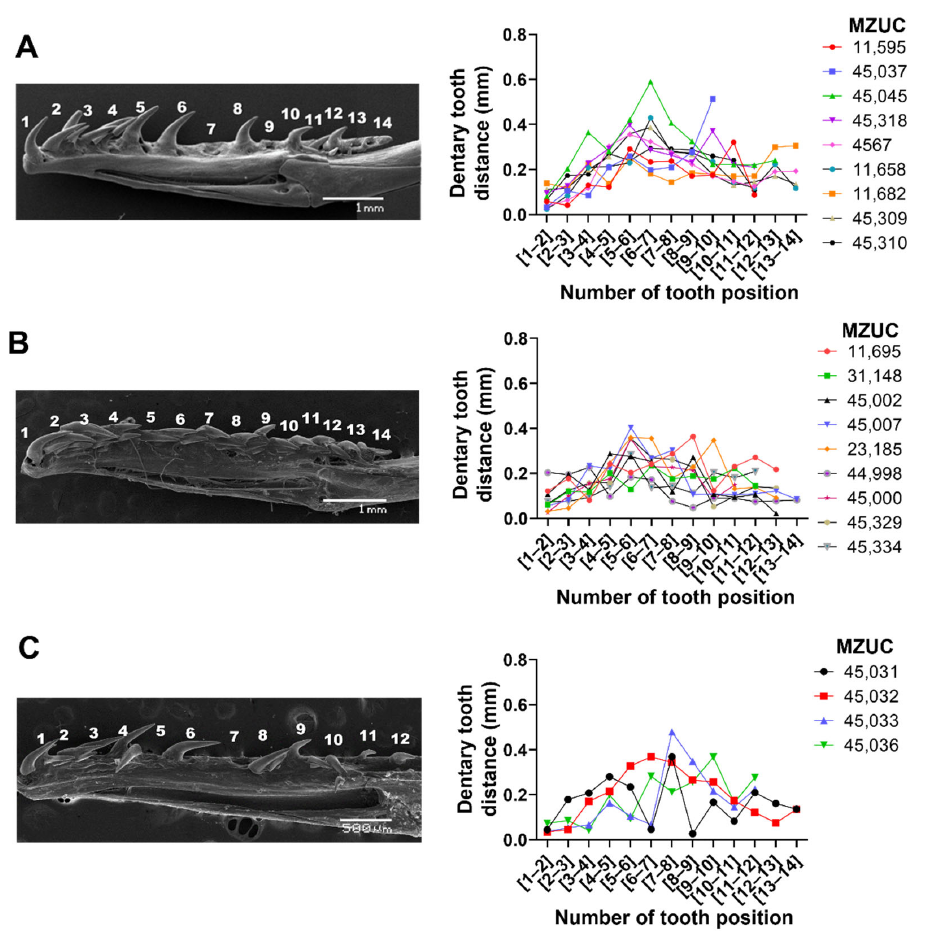
Figure 3. Variation of distances between teeth of the dentary in ( A ) adults, ( B ) juveniles, and ( C ) neonates of Galvarinus ch. chilensis (lingual view). The vouchers of specimens used for quantification are indicated in each graph. Data shown are mean ± SD from adults (N = 9), juveniles (N = 9), and neonates (N = 4). Representative images were obtained from ( A ) adult MZUC 11,658, ( B ) juvenile MZUC 45,007, and ( C ) neonate MZUC 45,033.